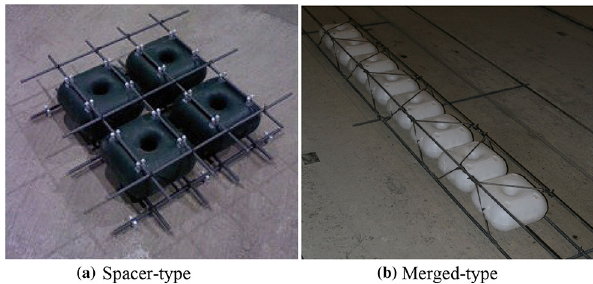
Fig. 2 Fixing methods of the donut type void